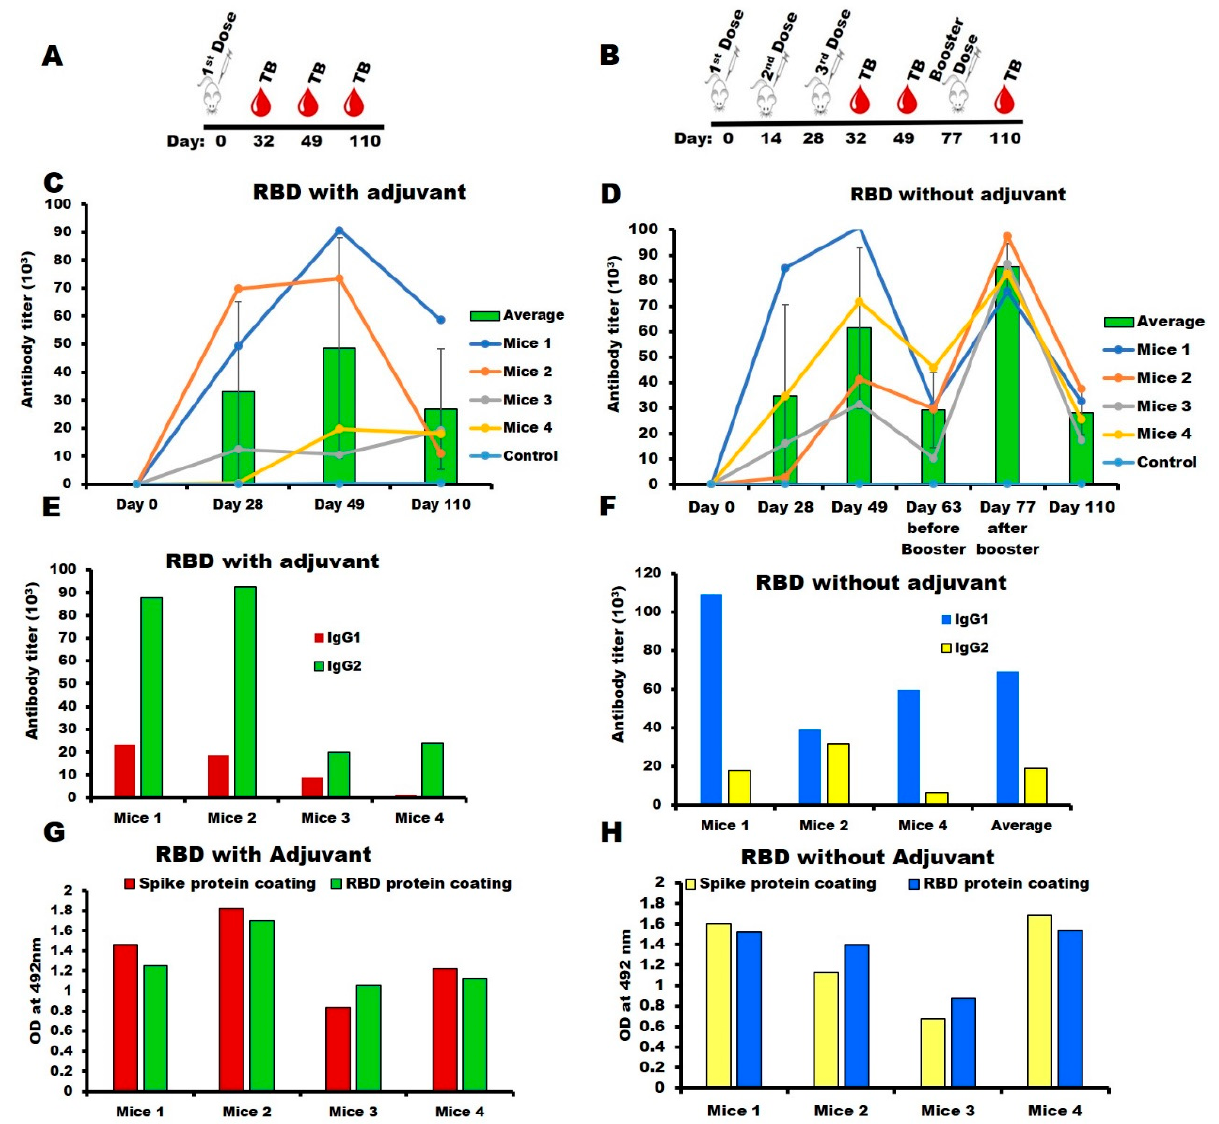
Figure 4. Anti-SARS-CoV-2 RBD sera (IgG) titer assayed by ELISA: IgG detection by ELISA was performed using the tail bleeding (TB) sera. M indicates the mice’s identity; and D indicates the tail bleeding day. Each circle indicates an individual mouse’s titer (total of four mice), and the bars show the average titer. ( A ) Immunization scheme in the presence of adjuvant; ( B ) Immunization scheme in the absence of adjuvant; ( C ) IgG Determination: with adjuvant and without adjuvant ( D ); IgG sub-class (IgG1, IgG2a) Determination: with adjuvant ( E ), without adjuvant ( F ); Recognition of mammalian-expressed spike proteins by anti-RBD sera, binding of day 49 serum with mammalian- expressed spike (S1) protein and E. coli -expressed RBD as coating antigen for comparison in the adjuvant ( G ) and without adjuvant ( H ) groups (legends are given in the